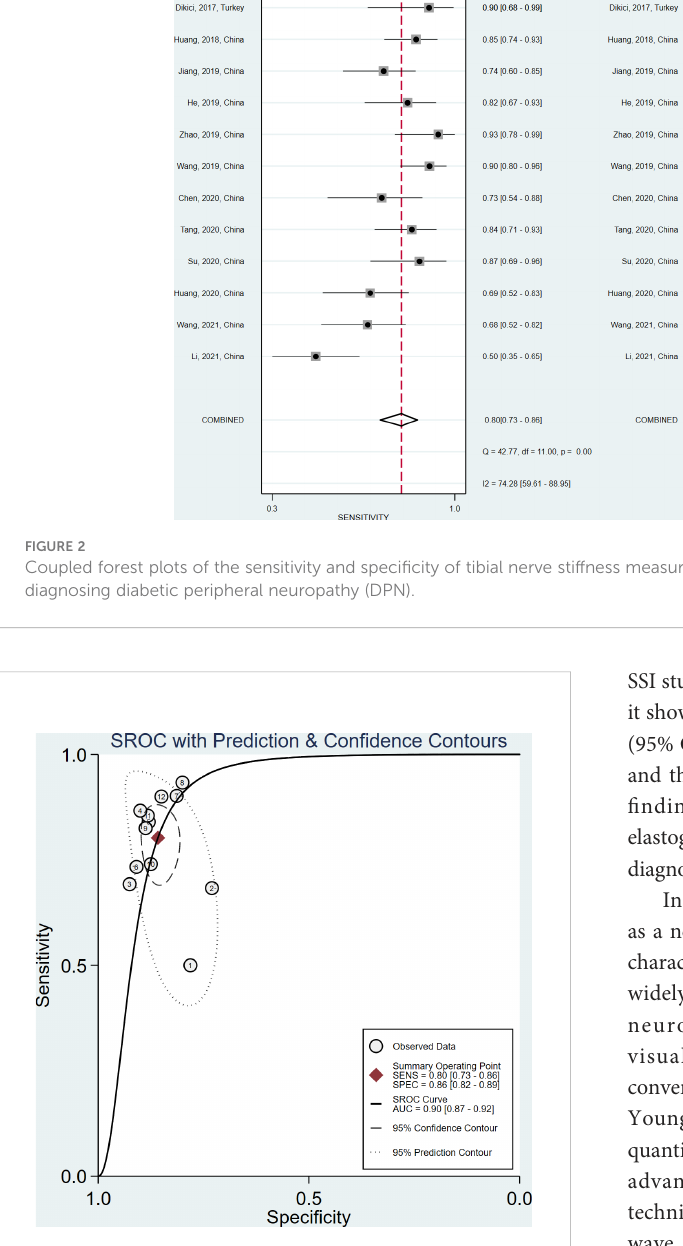
FIGURE 3 Summary receiver operating characteristic (SROC) curve of tibial nerve stiffness measurement by Supersonic Shear Wave Imaging (SSI) for diagnosing diabetic peripheral neuropathy